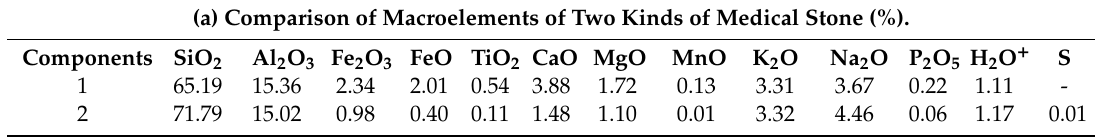
(b) Chemical Composition Comparison of Two Kinds of Medical Stone after Soaking at 20 ◦ C for 48